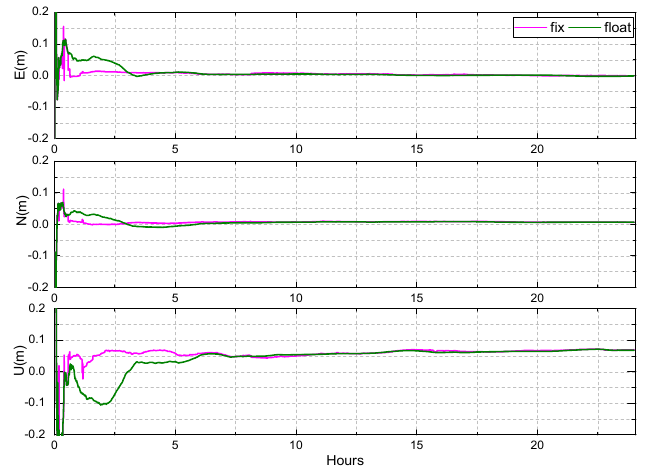
Figure 18. The results of BDS static PPP AR at KAT1, on DOY 083 of 2018.